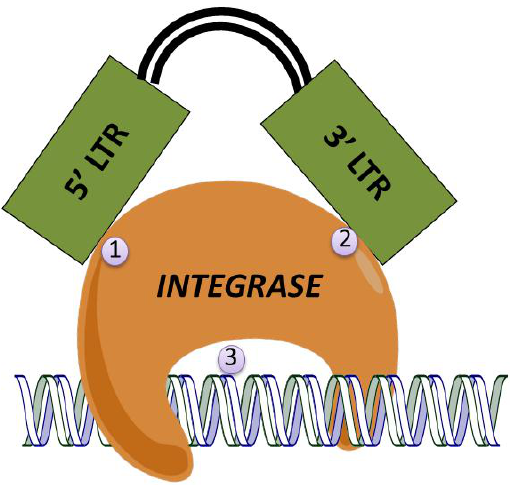
Figure 3. Targets for Creation of Non-Integrating Lentiviral Vectors. Three strategies have been devised to generate non-integrating vectors. Mutations are generated in ( 1 ) a 12 base-pair region of the U3 region of the 5' LTR; ( 2 ) an 11 base-pair region of the U5 region of the vector’s 3' LTR; or ( 3 ) point mutations in the integrase protein that interfere with processing of the vector DNA. This depiction is simplified as integrase and the vector DNA are part of a complex of